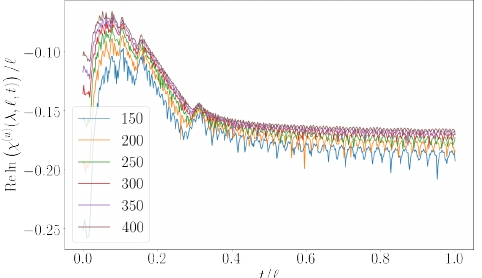
Figure 9: Reln χ ( u ) ( 1.4, (cid:96) , t ) /(cid:96) for several values of (cid:96) for a quench from h = 0.2 to h = 0.8. The data for different subsystem sizes are seen to collapse at sufficiently late times only for very large subsystem sizes (cid:96)